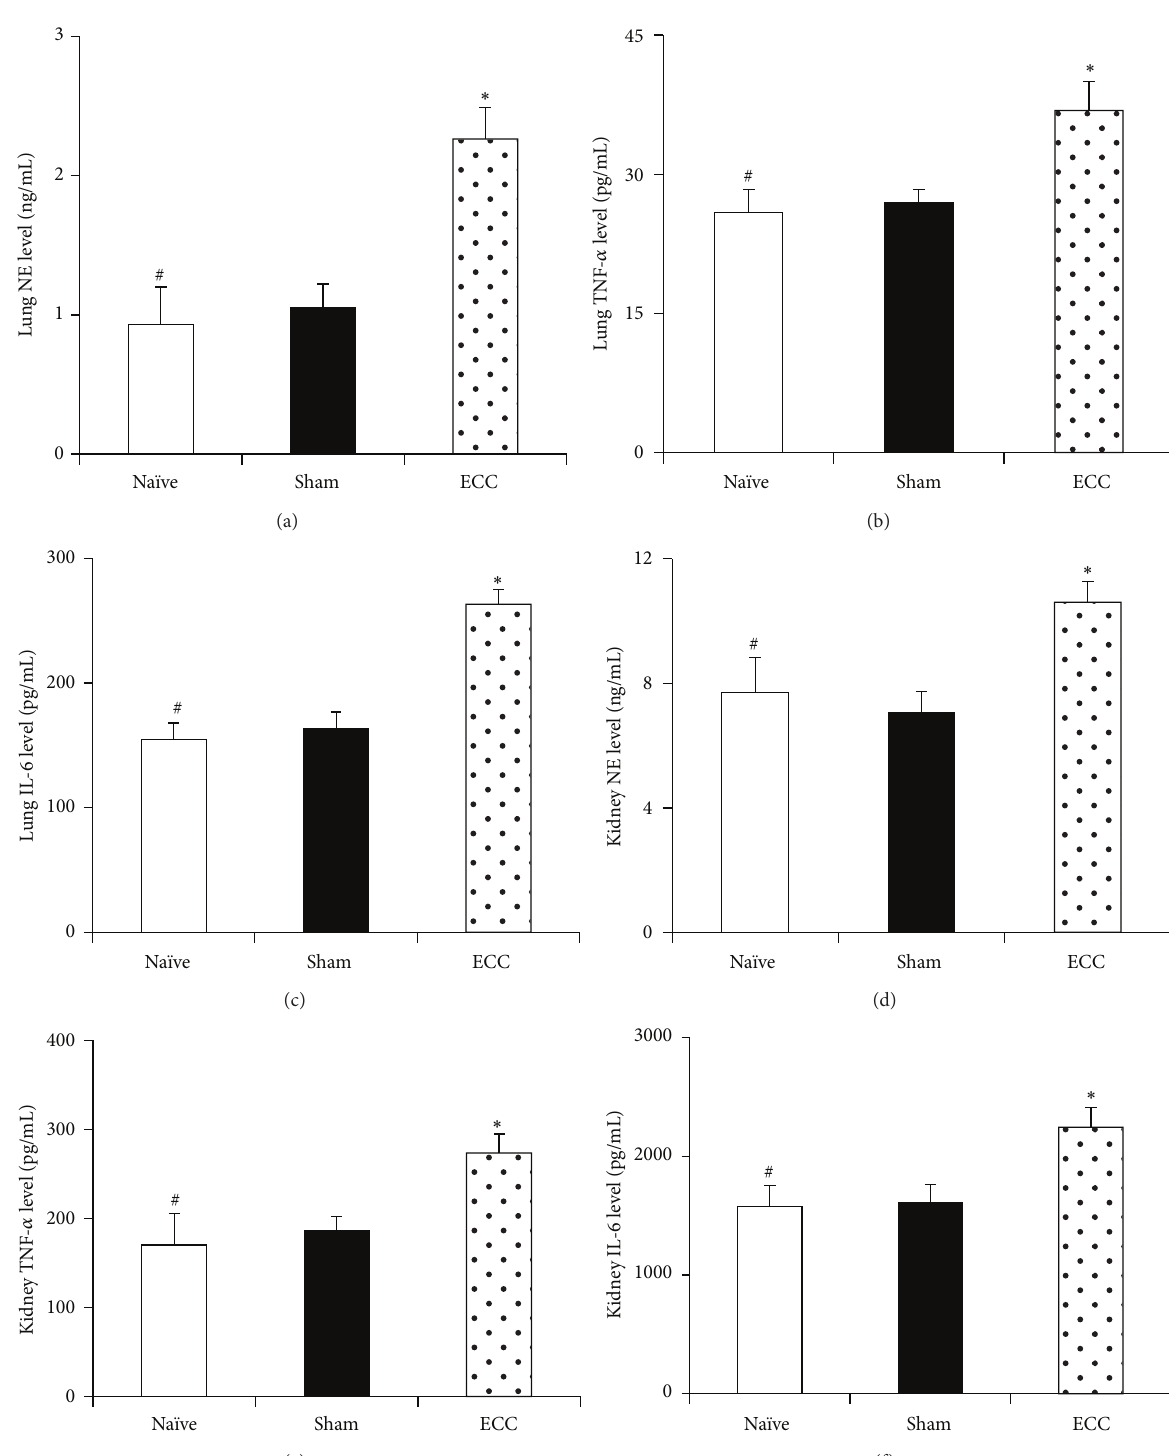
Figure 3: Inflammatory response in lung and kidney induced by ECC. Mice were treated as described in Figure 2, and lung and kidney tissues were harvested at the end of the experiment. Inflammatory response was assessed in lung (a–c) and kidney (d–f) by assaying levels of NE, TNF- 𝛼 , and IL-6. ECC, extracorporeal circulation; IL-6, interleukin-6; NE, neutrophil elastase; TNF- 𝛼 , tumor necrosis factor- 𝛼 . ∗ 𝑃 < 0.05 and ∗∗ 𝑃 < 0.01 versus Sham. # 𝑃 < 0.05 and ## 𝑃 < 0.01 versus